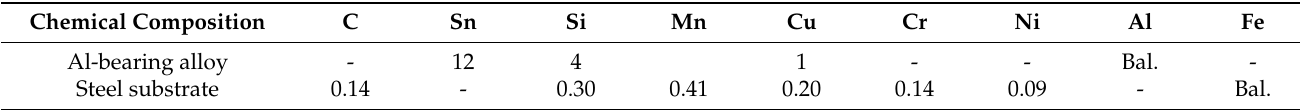
Table 1. Chemical composition of the carbon steel substrate, wt.%.